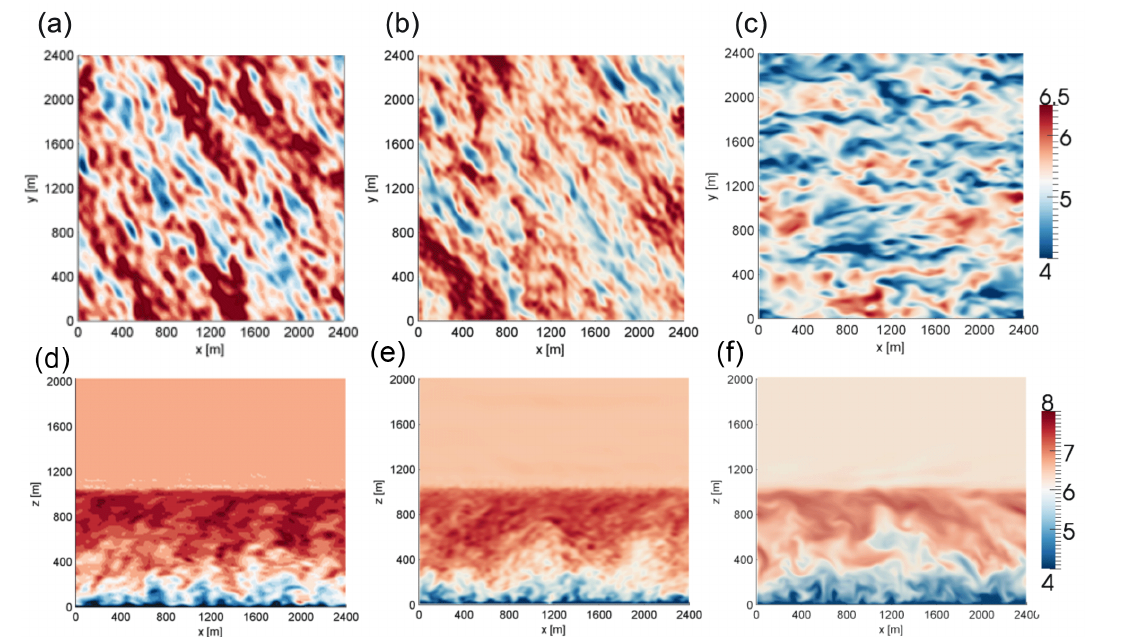
Figure 1. Comparisons of instantaneous horizontal wind speed [ms − 1 ] from the neutral case study, at 100m above the surface (a, b, c) and in a cross-stream plane midway through the domain (d, e, f) from WRF (a, d) , SOWFA (b, e) and HiGrad (c, f) . In each case, the external forcing was the same, grid resolution was 15m in each direction, and the advective scheme was the lowest-order option for each